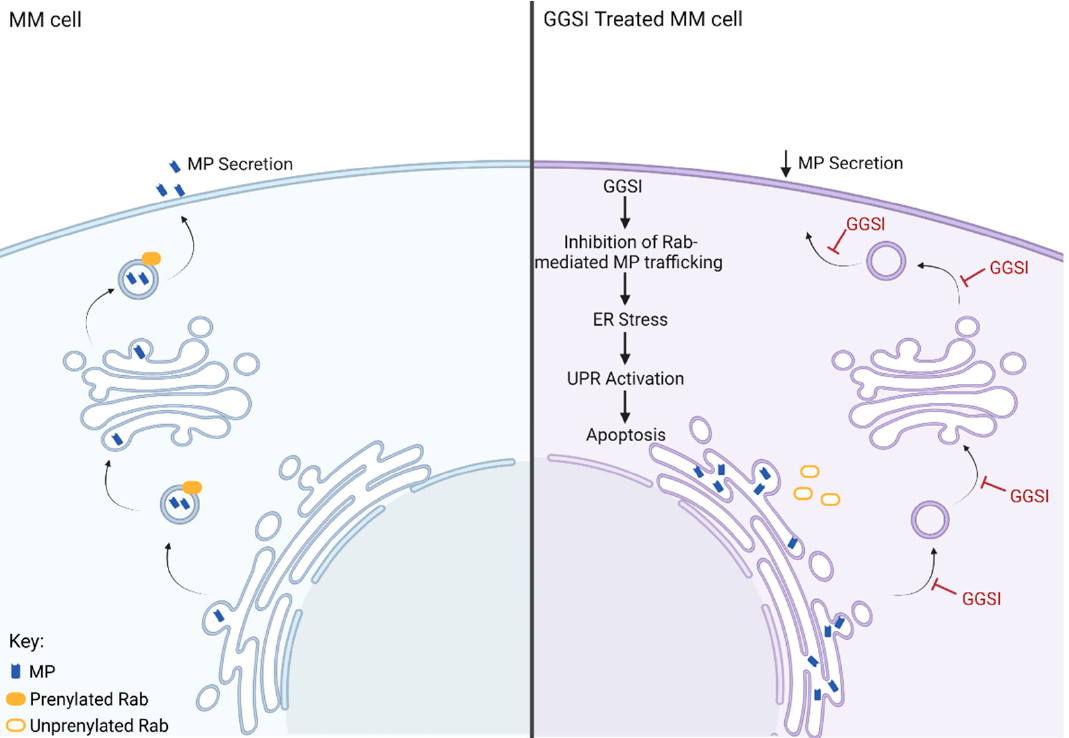
Figure 3. Cellular effects of GGSI in an MM cell. The cell panel on the left depicts normal Rab-mediated secretion of monoclonal protein (MP) from an MM cell. The panel on the right shows the effects of GGSI on MP secretion. In the GGSI-treated MM cell, Rab-mediated MP trafficking is inhibited, leading to ER stress caused by accumulation of MP within the ER, activation of the UPR, and ultimately apoptosis.